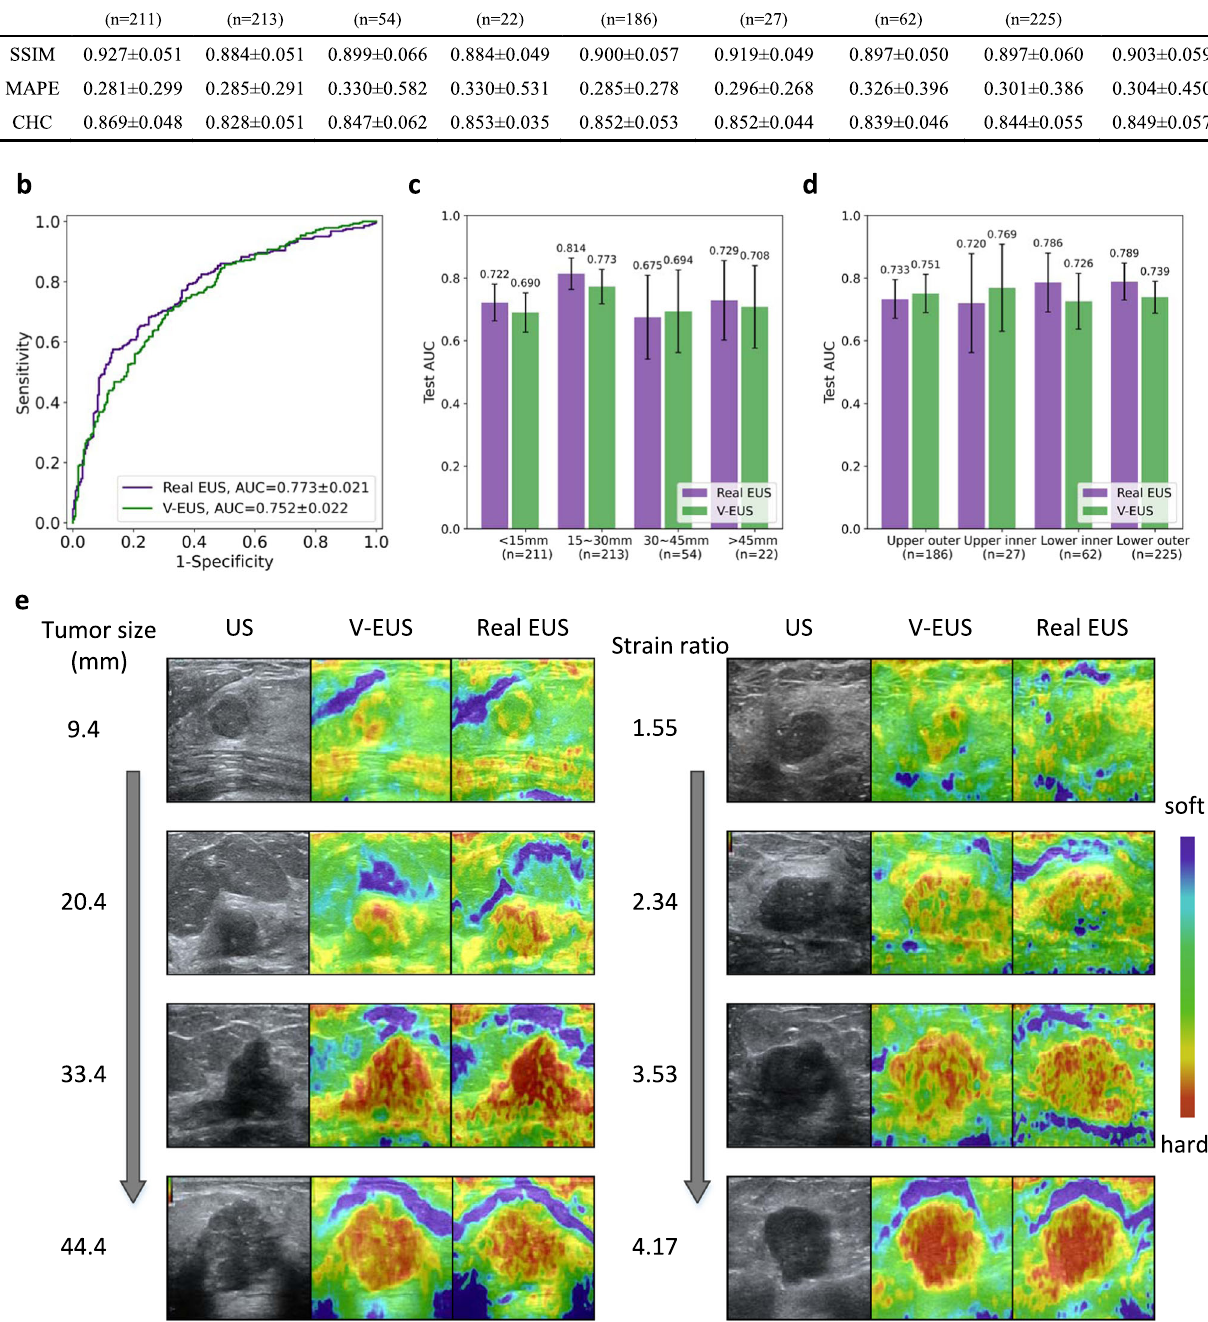
Fig. 2 | Performance of the deep learning model on the internal validation set. a Detailed quantitative metrics comparison strati fi ed by tumor size and tumor location. b ComparisonofROCsbetweenrealEUSandV-EUSindeterminingbreast tumor malignancy. c Comparison of diagnostic performance strati fi ed by tumor size. n indicates the number of cases in the interval. Error bar indicates 95%